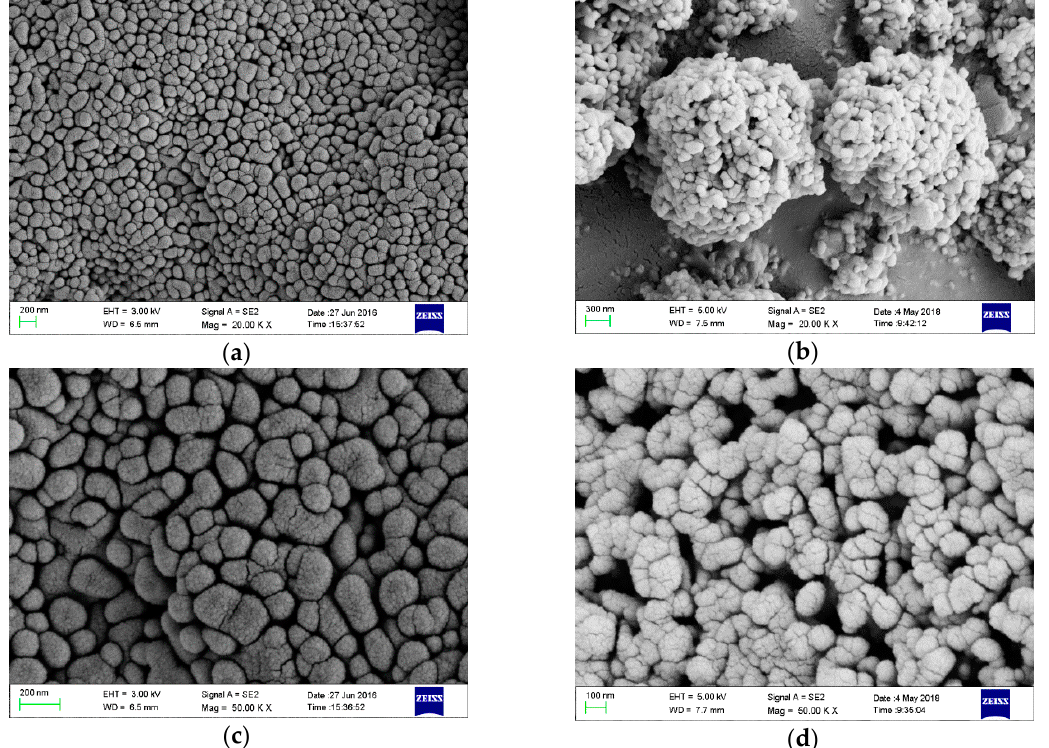
Figure 11. Scanning electron microscope (SEM) images of ( a ), ( c ) carbide slag and ( b ), ( d ) HT5 after 10 cycles with different magnification factors, ×20,000 and ×50,000 (carbonation in 15% CO 2 /N 2 at 700 °C for 20 min, calcination in 70% CO 2 /N 2 at 920 °C for 10 min).